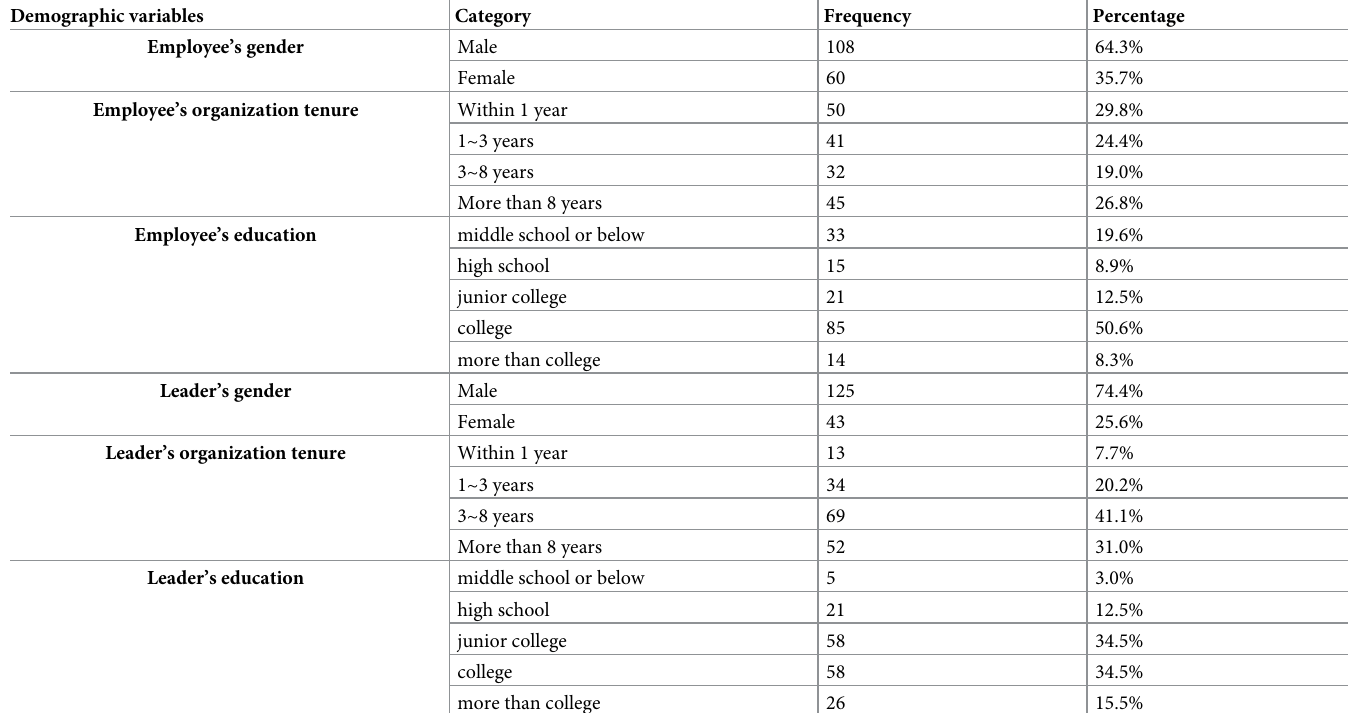
Table 1. Background information of the employee and leader